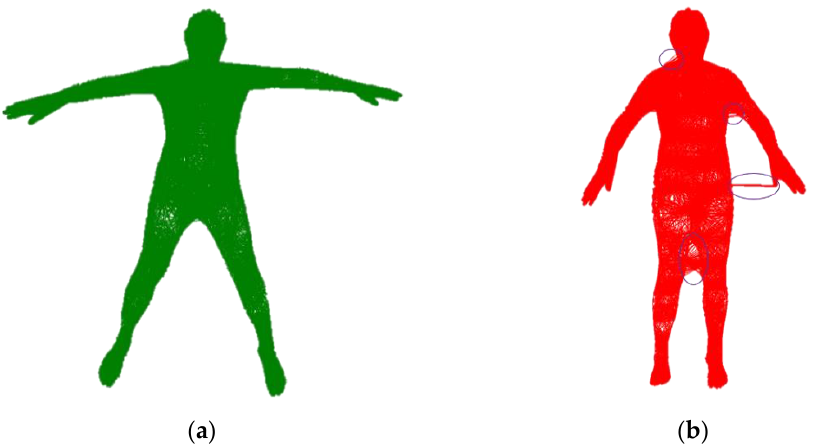
Figure 2. Vertex graph in different postures. ( a ) KNN nodes of vertex in a stretched pose. ( b ) Vertex graph constructed with fewer constraints of posture. The Figure shows that a loose posture may lead to unnatural KNN nodes of the vertex.